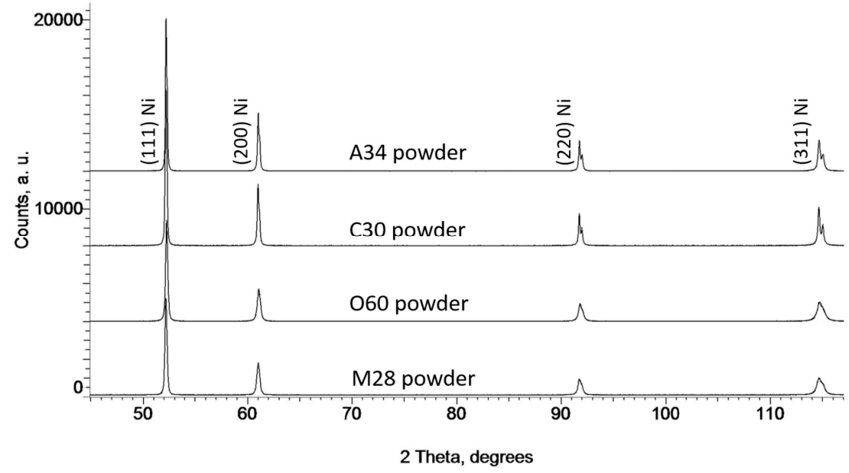
Figure 5. X ‐ ray diffraction patterns obtained for both the nickel powders feedstock. Figure 5. X-ray di ff raction patterns obtained for both the nickel powders